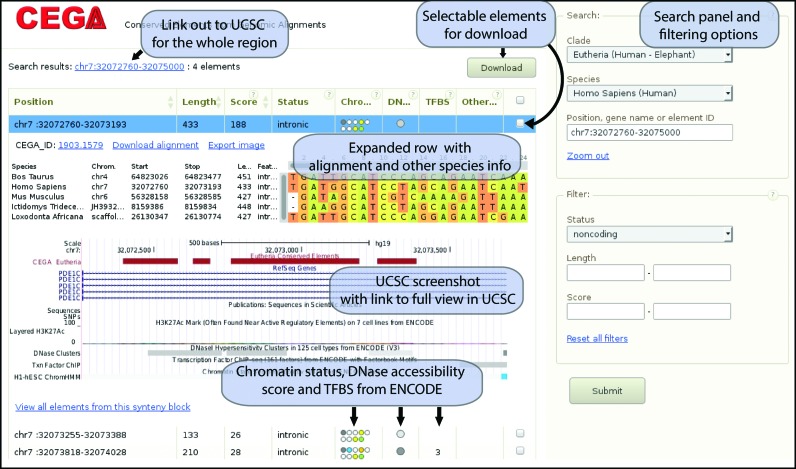
CEGA user interface.